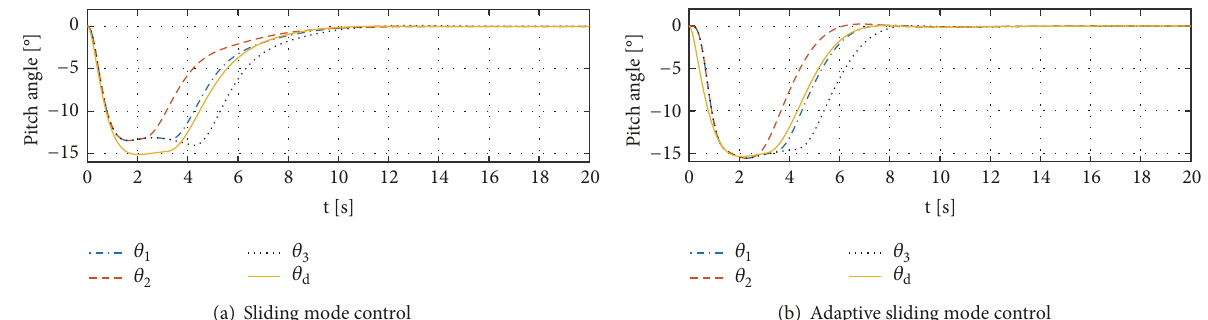
Figure 5: Synchronized attitude of pitch angles of each